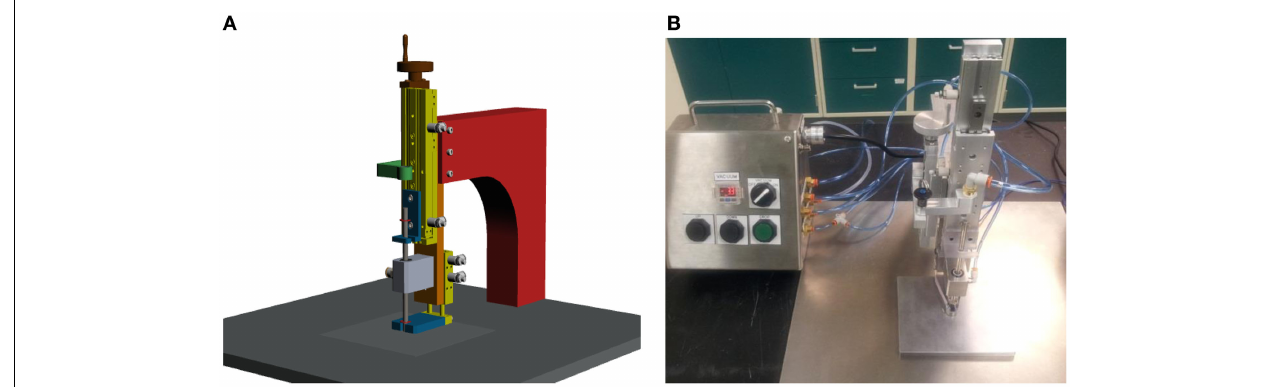
FIGURE 1 | (A) Schematic diagram and (B) photograph of the automated frangibility testing apparatus.